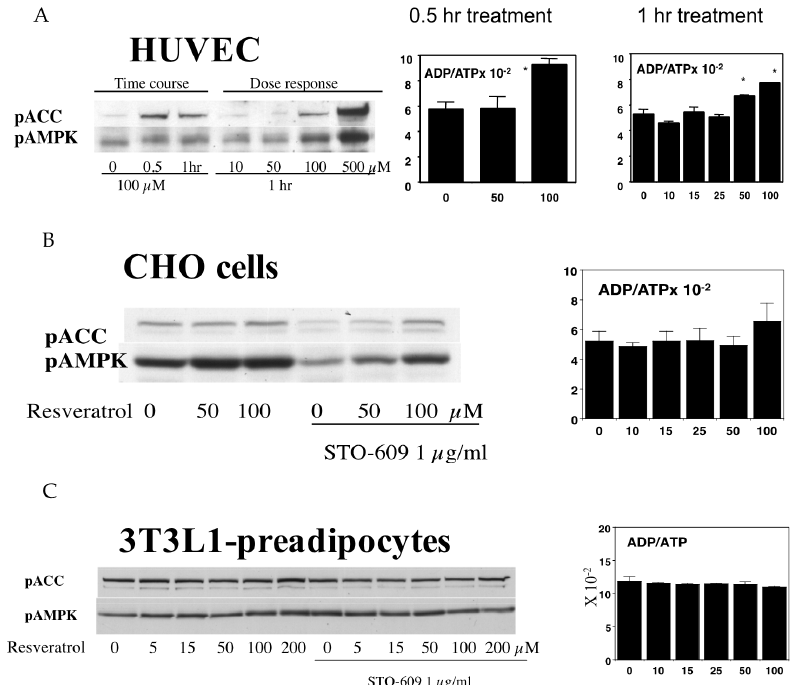
Figure 5. ( A ) Activation of AMPK by resveratrol in HUVEC. HUVECs were incubated in the indicated concentrations of resveratrol for either 0.5 or 1 h. Western blotting analysis shows that the phosphorylation of both ACC and AMPK was increased by 100 µM resveratrol. In the 0.5 h treatment, 100 µM but not 50 µM resveratrol increased the ADP to ATP ratio ( n = 3, p < 0.05). In the 1 h treatments, both doses of resveratrol significantly increased this ratio ( n = 3, p < 0.05), and this was found to be due to increased ADP levels as the ATP levels were unaffected; ( B ) Effects of resveratrol on AMPK in CHO cells. CHO cells were stimulated by the indicated concentrations of resveratrol for